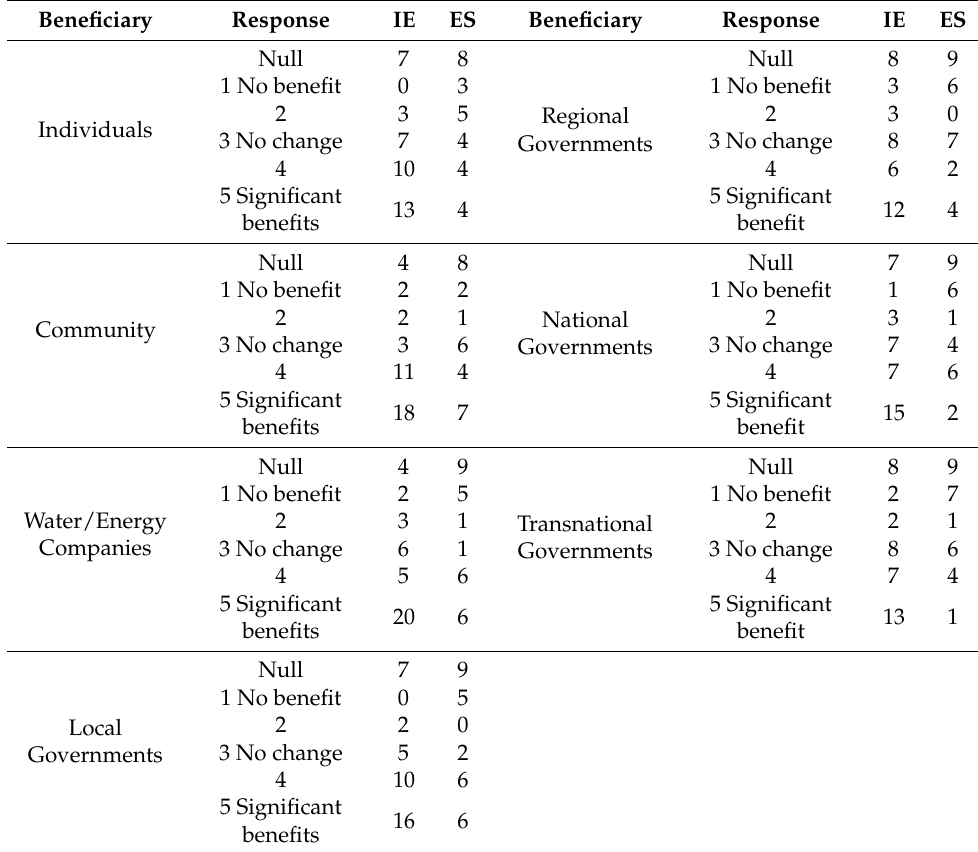
Table 1. Potential beneficiaries of MHP (IE = 40; ES =